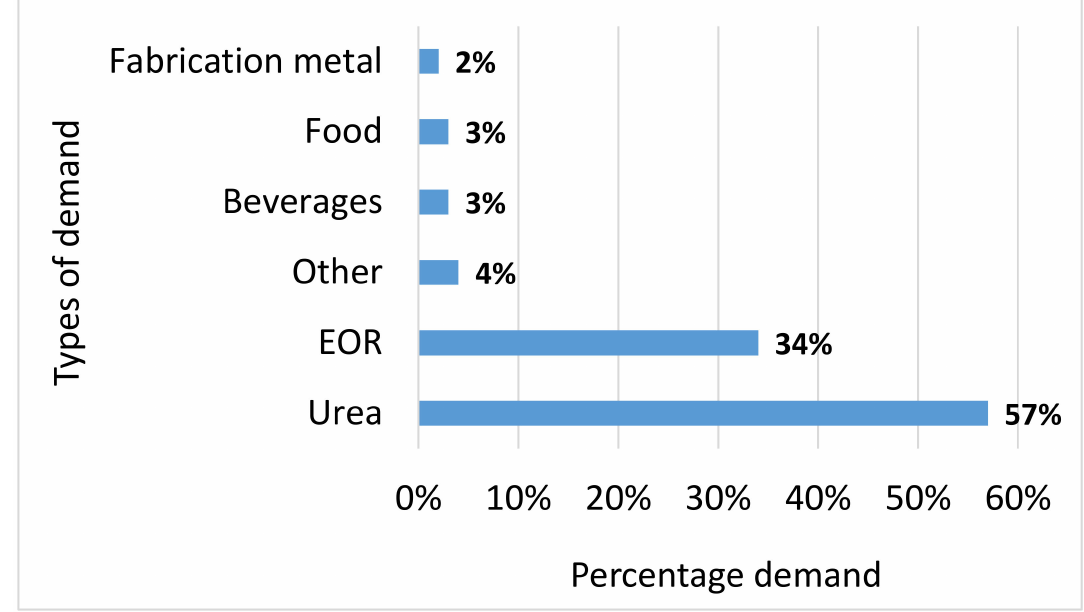
Figure 8. Breakdown of global CO 2 demand in 2015 according to type, source of data: IEA